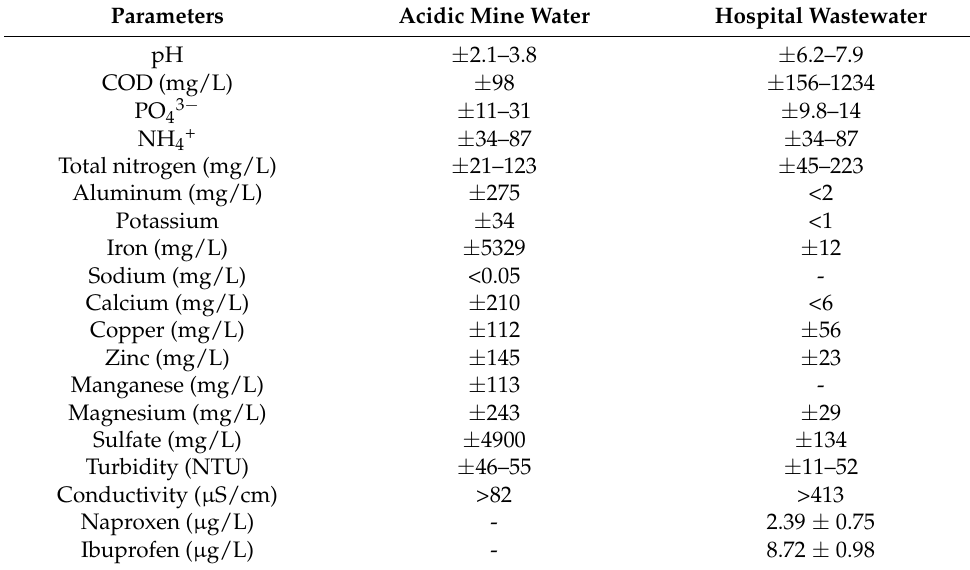
Table 1. Characterization of the acidic mine water samples.